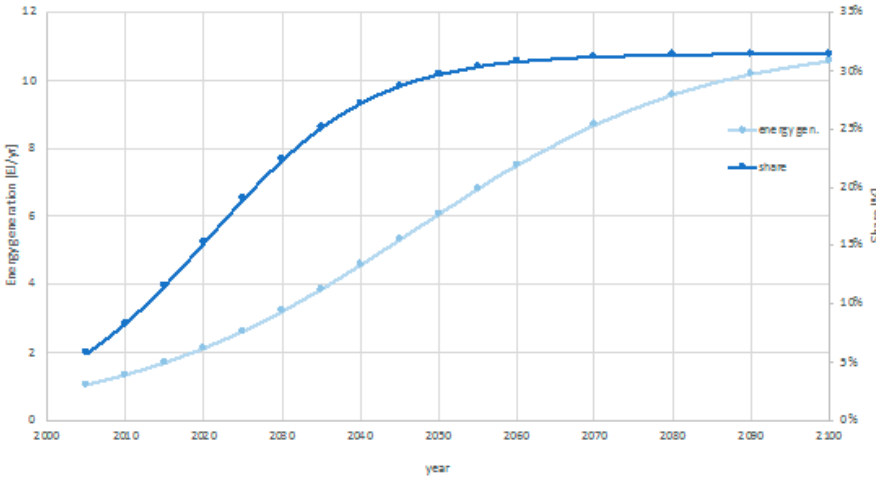
Table 9. Parameters calculated for the S-shaped wind technology curves (Figures 9 and 10).